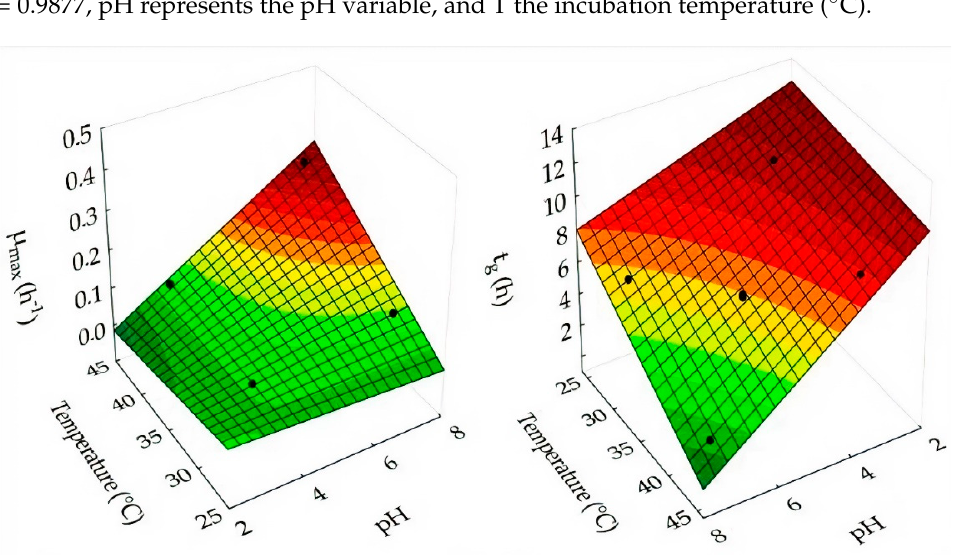
Table 3. Biological characteristics of L. gasseri in the fermentation of passion fruit juice added with green tea.